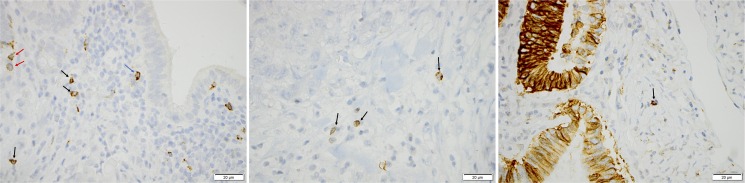
Sample immunohistochemical images.Immunohistochemical images of CD56 staining in periampullary adenocarcinoma. Sample images (40X magnification) visualising the presence of intra-tumoural (red arrow), stromal (black arrow) and tumour-adjacent (blue arrow) CD56+ NK/NKT cells in three different cases with A) papilla-ampulla intestinal origin, total CD56+ NK/NKT cell count 10, and tumour-specific CD56 expression 0, B) distal bile duct origin, total CD56+ NK/NKT cell count 6 and tumour-specific CD56 expression C) pancreas origin, total CD56+ NK/NKT cell count 5, and tumour-specific CD56 expression 100%.